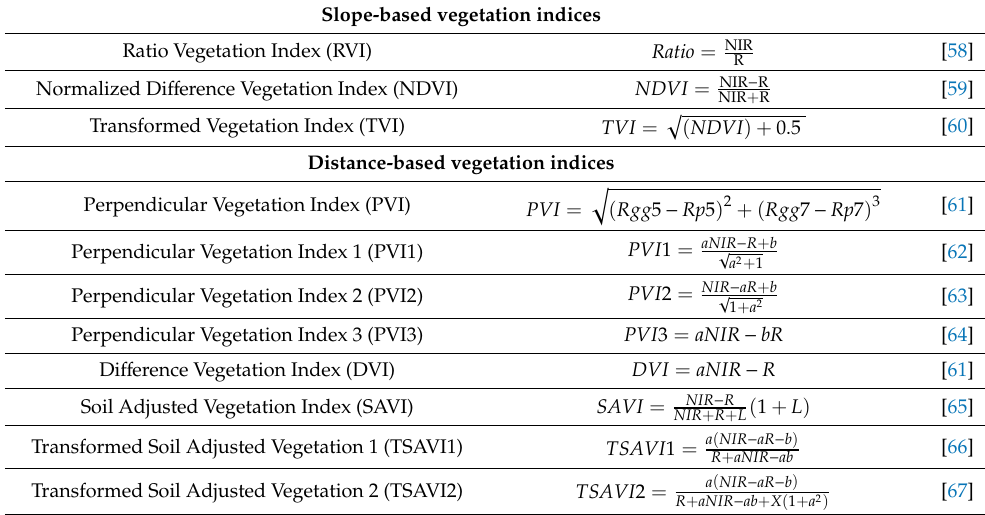
Table 2. Vegetation and soil indices used to identify the full extent of Mas medieval